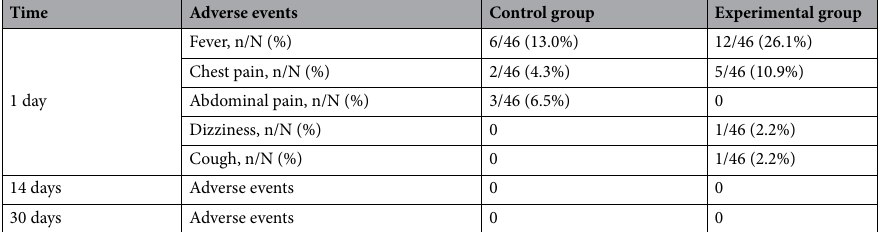
Table 3. Adverse events. Data are n/N (%). The adverse events of the day after endoscopy were measured among all the patients who were randomly assigned and completed the endoscopic submucosal dissection. And the follow-up 14 days later or 30 days later only measured the participants that continued the